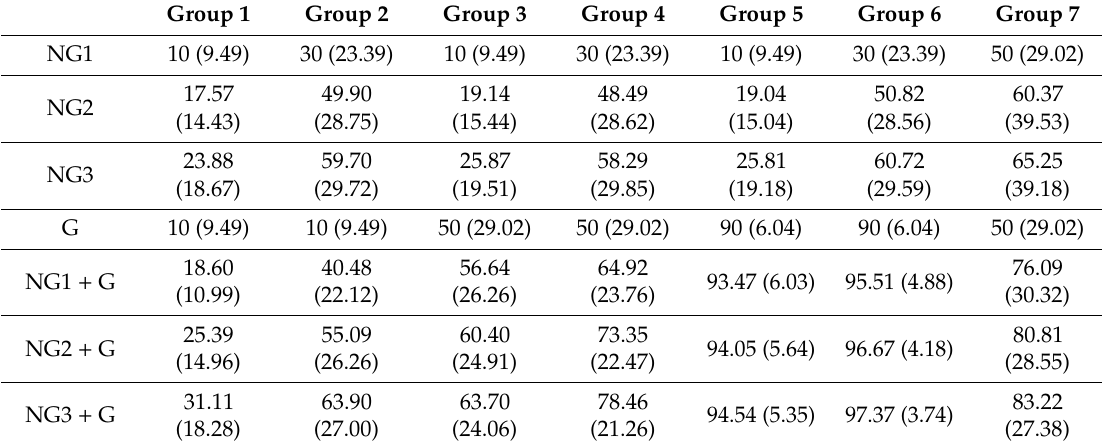
Table 1. Mean (st. deviation) values (%) for the distributions of probabilities (link and risk) to present clinical signs when one, two or three non-genetic (NG1, NG2, NG3) and genetic (G) risk factors are associated with the